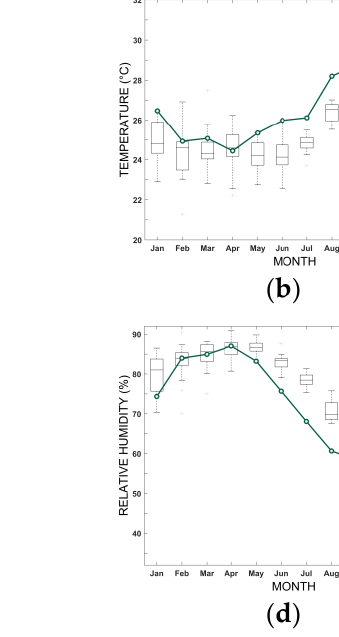
Figure 7. Intra-annual variability of SRDAS variables over the northern region (area 1 from Figure 1): ( a ) precipitation (mm/d); ( b ) temperature at 2-m above ground (°C); ( c ) 2-m integrated soil moisture (mm); and ( d ) relative humidity at 2-m above de ground (%). Each monthly boxplot represents the historical distribution for the 1999–2013. The green curve depicts the above variables for the year of 2005.